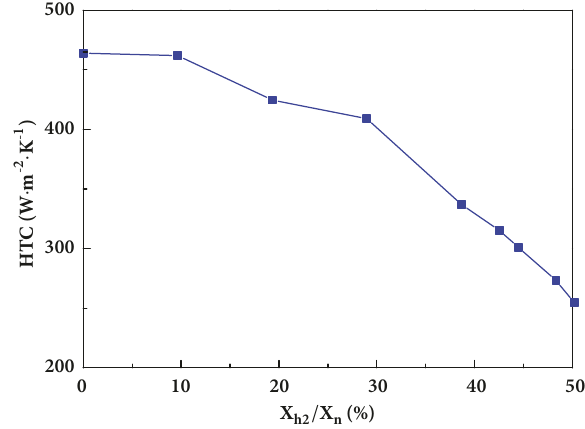
Figure 20: Heat transfer coefficient with different hydrogen molar